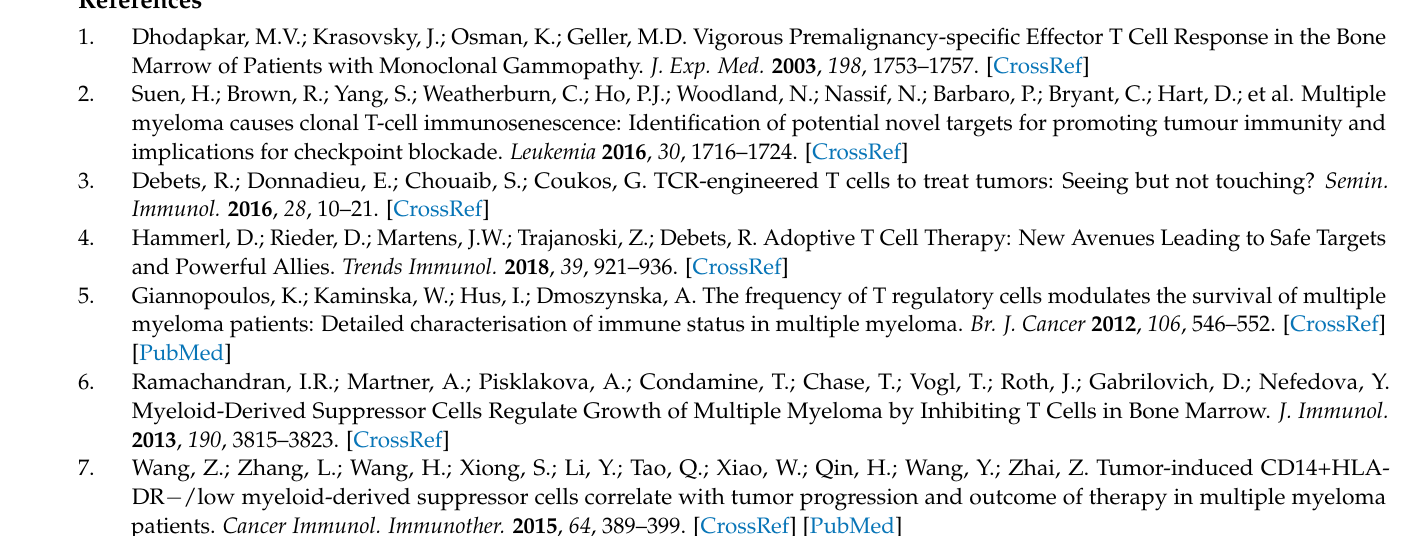
Table S2: Purity of CD138+ plasma cells does not confound prognostic value of VISTA gene expression, Table S3: Characteristics of patients treated in the HOVOB87/NMSG18 trial, and whose tumors were used for in situ